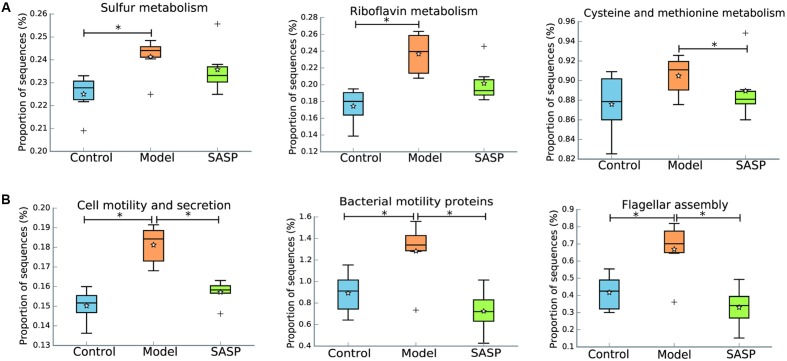
Inferred gut microbiome functions by PICRUSt from 16S rRNA gene sequences among the different three groups (the control group, the model group, and the SASP group). (A) Biosynthesis of compounds for oxidative stress including riboflavin metabolism, sulfur metabolism, cysteine and methionine metabolism. (B) Dysregulated cellular processing pathways were presented in the model group, including cell motility and secretion, bacterial motility proteins and flagellar assembly. Box plots denote the top quartile, median and bottom quartile, and white stars mean the average value as well as the ‘+’ means the outlier. All the differences were analyzed using one-way ANOVA followed by Tukey–Kramer post hoc test, Benjamini–Hochberg FDR method was used to correct multiple comparisons (∗P < 0.05).